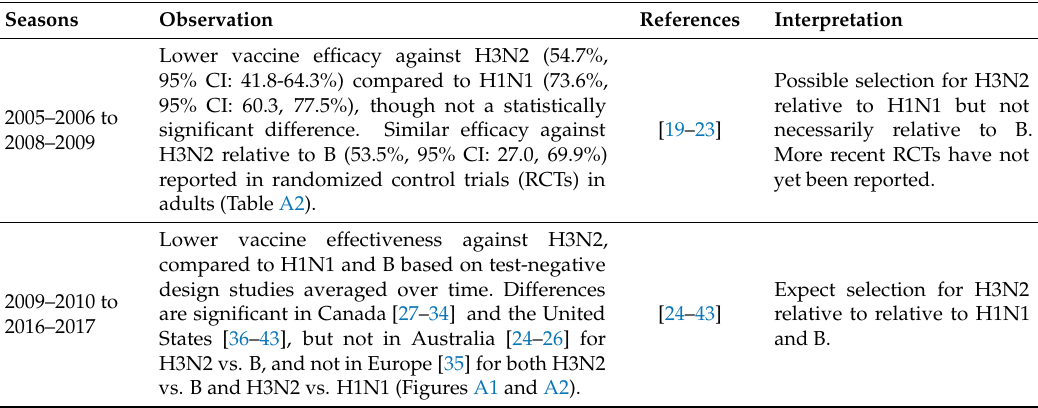
Table A3. Evidence for potential vaccine-driven selection among influenza types and subtypes.